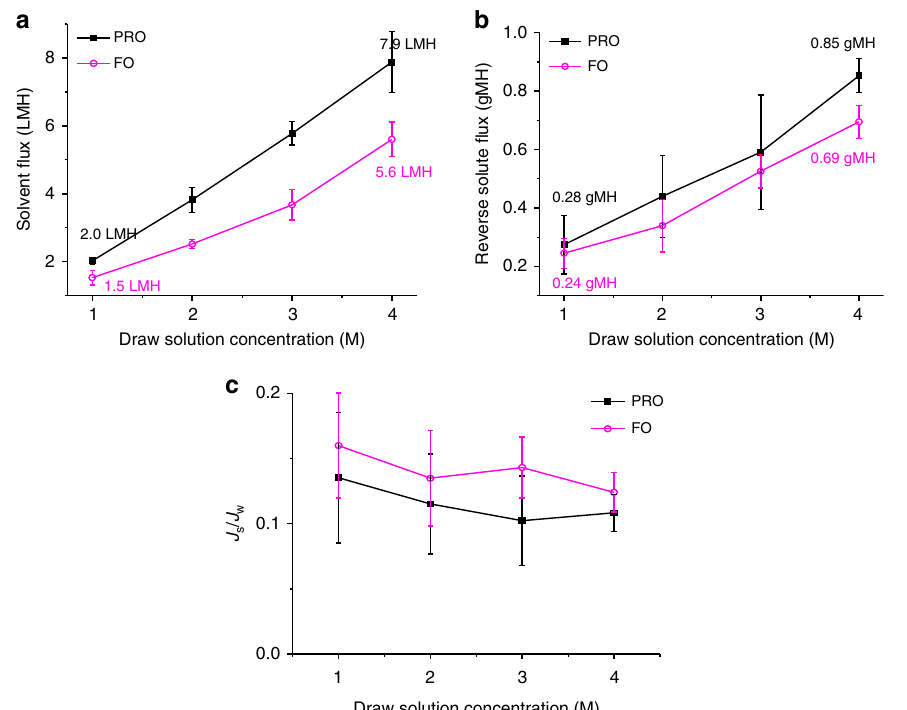
Fig. 2 Assessment of the effect of the draw solution concentration. a Solvent fl ux, b reverse solute fl ux and c selectivity J s / J w as a function of draw solution concentration where the feed solution is pure ethanol and the draw solution is LiCl in ethanol. The error bar represented the standard deviation from at least three independent OSFO tests with different membrane coupons, and the interfacial polymerization was conducted separately for each membrane coupon. Our results demonstrate that the solvent fl ux and the reverse solute fl ux increase proportionally to the draw solution concentration but the membrane selectivity is not compromised